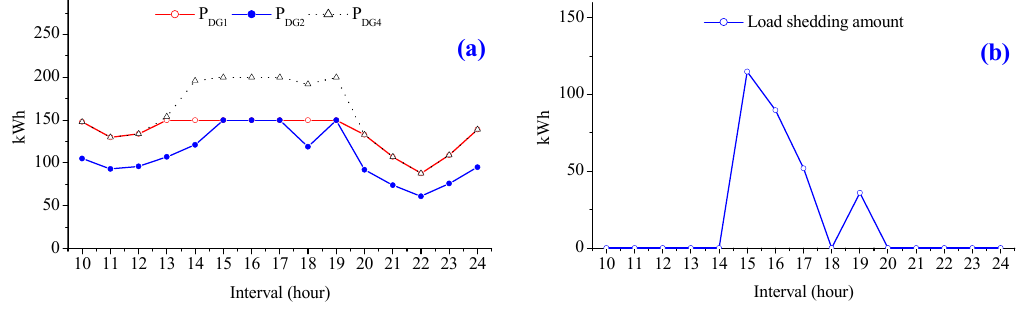
Figure 14. Operation results of isolated part for remaining intervals: ( a ) output power of DG units; and ( b ) load shedding amount.